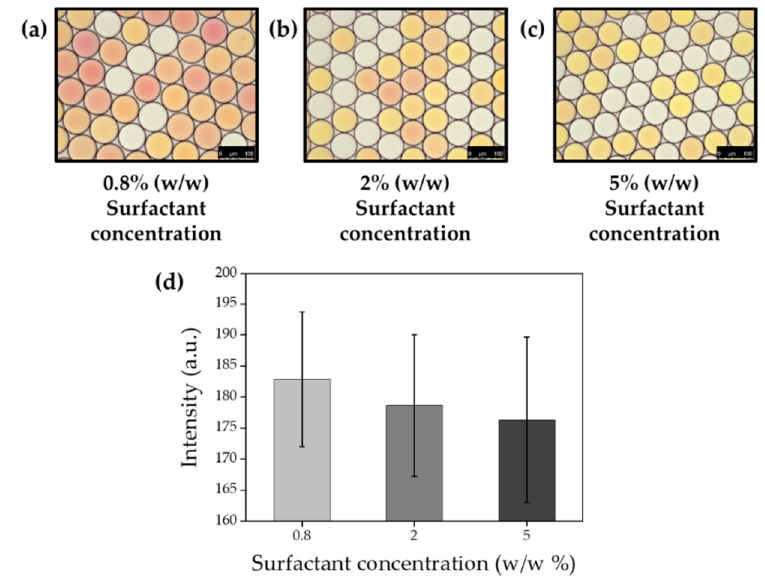
Figure 14. Relationship between surfactant concentration and gas permeability. Microscopic images of droplet mixtures that were generated with HFE-7500 contains 0.8% ( a ), 2% ( b ) or 5% ( c ) surfactant, respectively. ( d ) Mean values of color exchange of indicator droplets for surfactant concentration. (scale bar = 100 μ m).